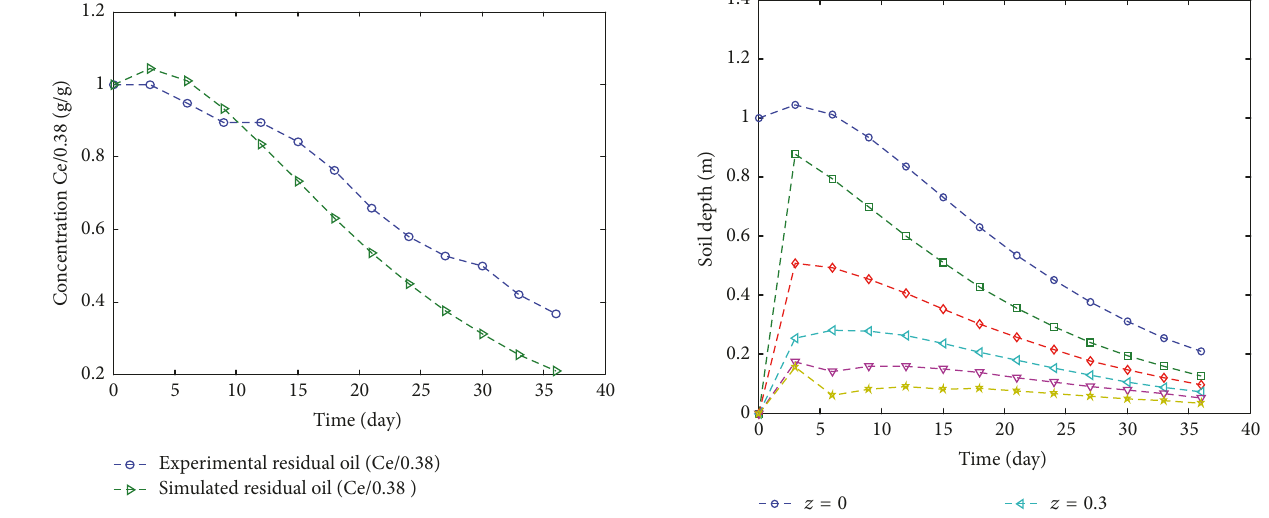
Figure 4: Comparative analysis of experimental and simulated results at Ce/0.38 (dimensionless).